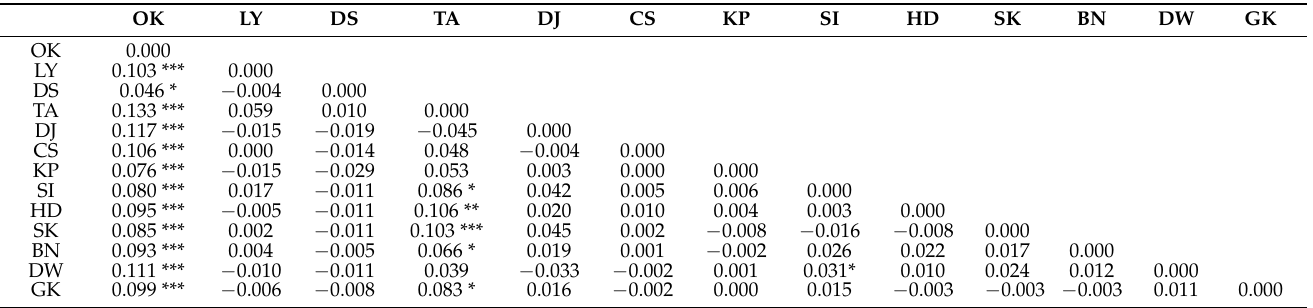
Table A2. Matrix of pairwise F ST among six populations based on mitochondrial COI gene (below diagonal) in Macrobrachium